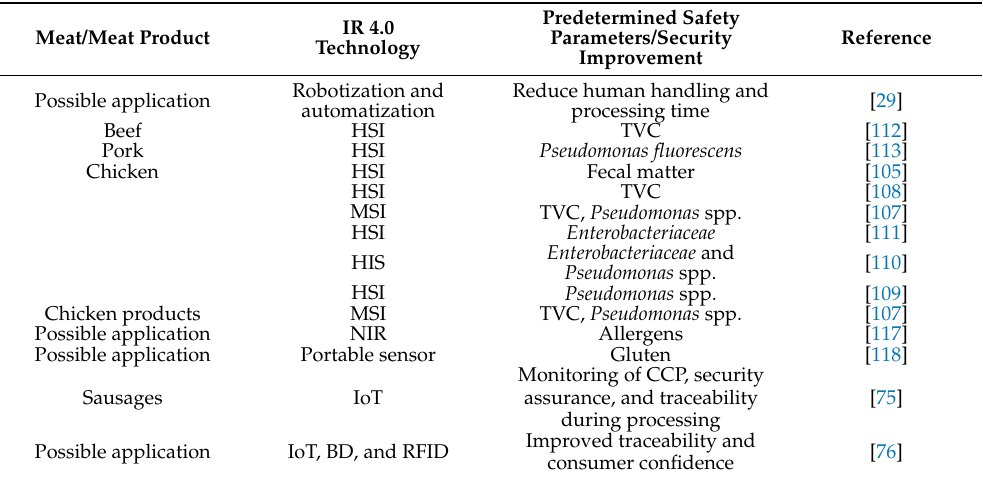
Table 3. Application and possible applications of IR 4.0 technologies for meat safety. Meat/Meat